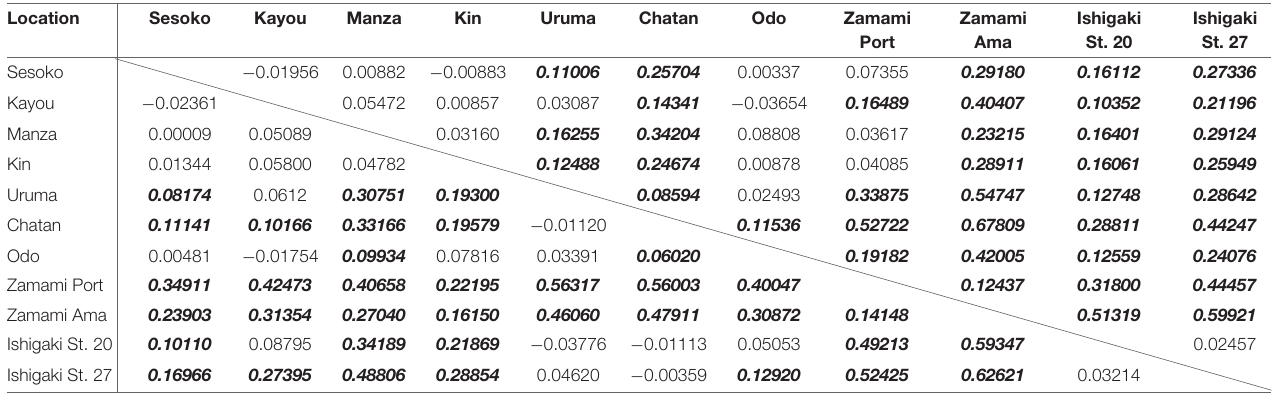
TABLE 2 | Pairwise 8 st value of each comparison of sequences of H . atra between locations. Location